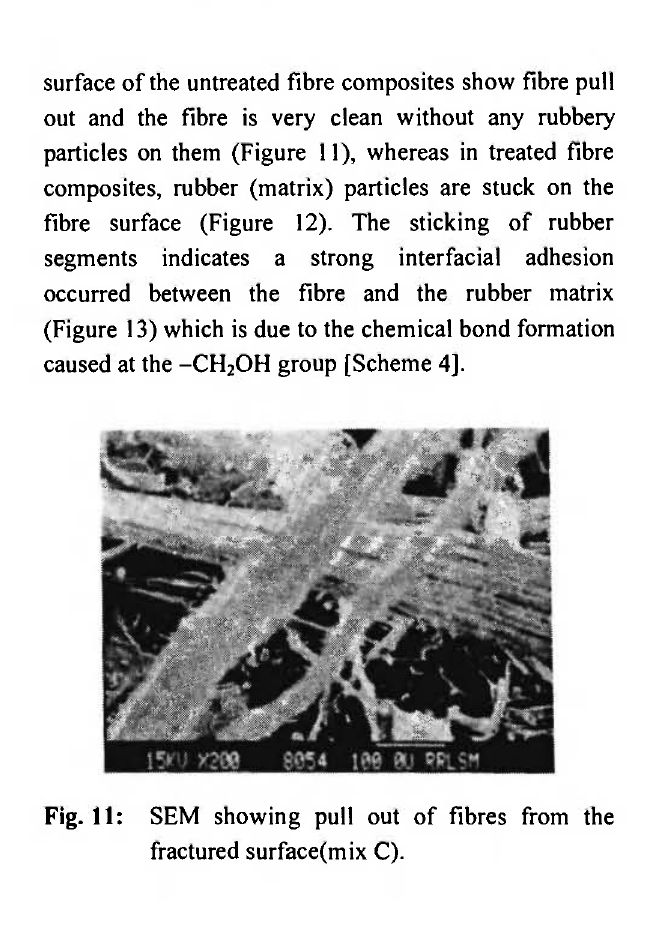
log(FREQUENCY) Fig. 10: Effect of various chemical treatments on dissipation factor of composites as a function of frequency